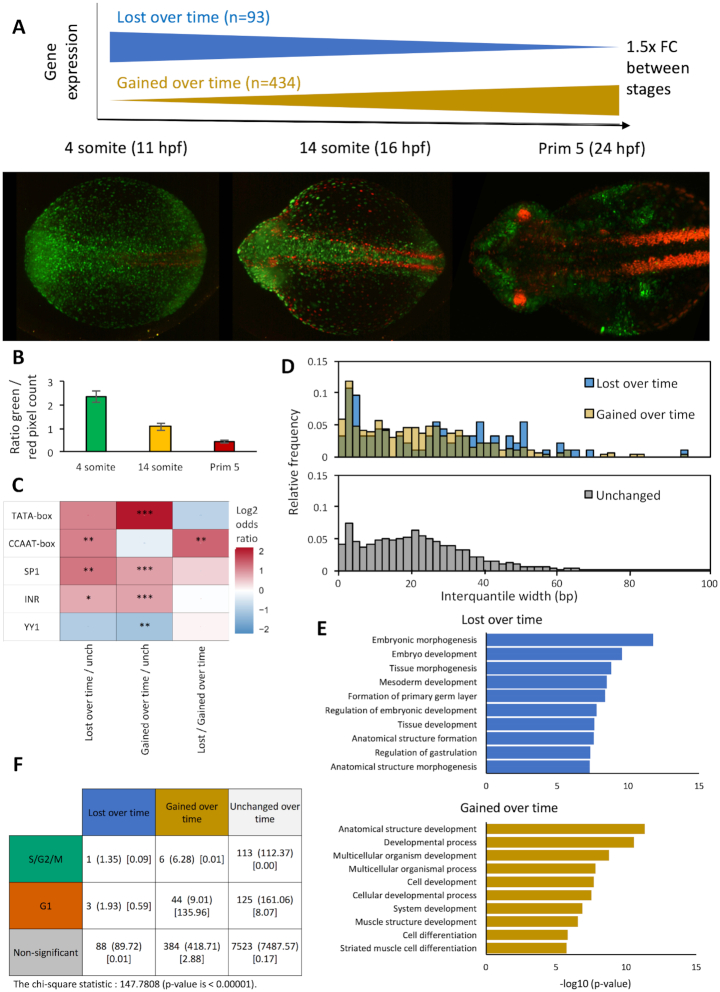
Genes with opposing temporal expression dynamics are marked by differential promoter motif utilization and TSS distribution. Published CAGE data from (30,31) was processed to generate a differential expression and promoter behaviour matrix for 4-somite, 14-somite and prim-5, three stages of zebrafish segmentation with differing ratios of rapid to slowly cycling cells, as demonstrated by Fucci imaging (A) and fluorophore pixel ratios (B). (A) Relative expression analysis of consensus clusters with a TPM > 5 in at least one time stage was performed. Genes where expression changes in the same direction by >1.5 fold in each sequential time stage were selected for further analysis and divided into gene where expression is lost over time (n = 93) and gained over time (n = 434) (4 somite → 14 somite [11–16 h post fertilization]→ Prim 5 [24hpf]). (B) Bar graph showing ratio of green / red fluorophore pixel density from imaged Fucci embryos at 4 and 14 somite and Prim 5 stages. (C) Heatmap visualizing the log2 odds ratio of selected promoter motif occurrence for genes with expression lost, or gained over time versus genes with no temporal dynamics (n = 7762) (*P< 0.05, **P< 0.01, ***P< 0.001, Fisher's exact test). (D) Consensus cluster interquantile width (IQW) in genes with expression lost (blue, mean IQW: 27.5), gained (yellow, mean IQW: 23.0) over time, or no temporal expression dynamics (grey, mean IQW: 22.8), visualized as a histogram. IQW was taken from the developmental stage where consensus cluster expression was highest. (E) Gene ontology analysis of genes with expression lost / gained over time. (F) Table showing chi-square intersection analysis between gene sets with temporal dynamics over the segmentation period of zebrafish development and cell cycle dynamics during the 14 somite stage. Data format: expected intersection size (chi-square statistic).